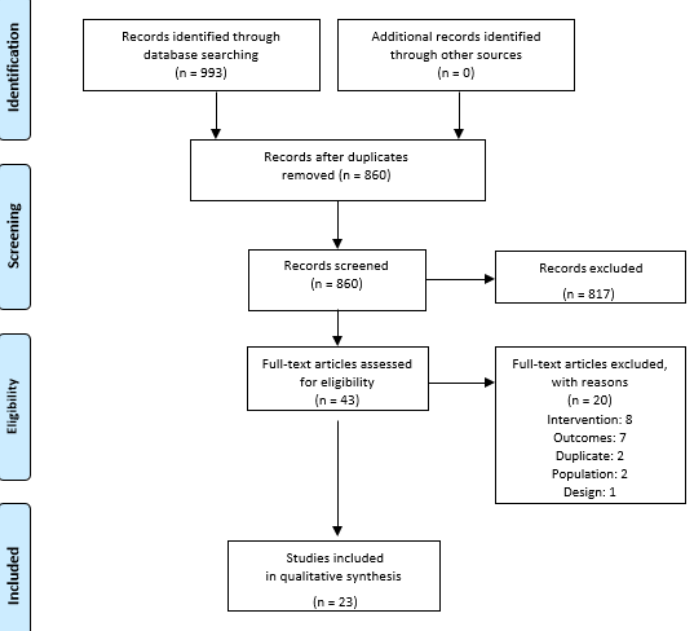
Figure 1. The PRISMA Flow Diagram .